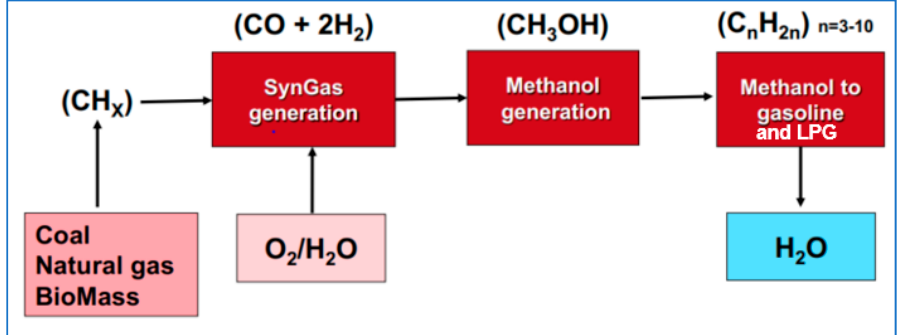
Figure 8. Schematic of the gas/coal/biomass ‐ to ‐ methanol ‐ to ‐ gasoline/LPG process. Source: ExxonMobil. Most of the world’s methanol is produced this way, but not from biomass, rather from ‘stranded’ natural gas (or sometimes coal), gas or coal that are too remote to be used locally or to be transported somewhere else. In most cases, the methanol is sold onward as methanol, but there are cases where it is converted on to gasoline and LPG: